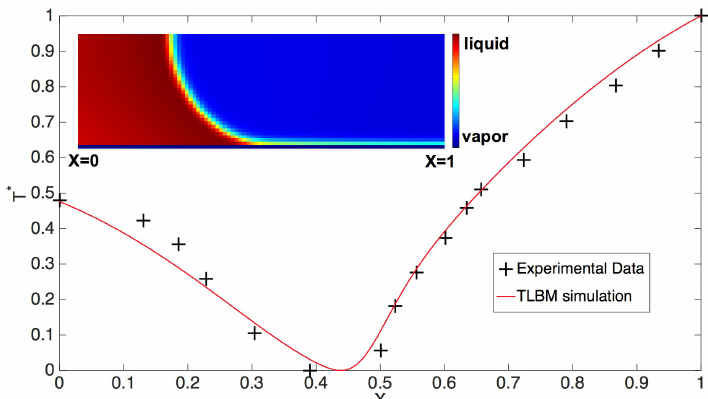
Figure 8. The wall temperature distribution under constant flux: black crosses are experimental data from [5]; red line is obtained by the thermal lattice Boltzmann method (TLBM) simulations; X and T ∗ are normalized location and temperature, respectively; density profile of the half channel is presented in the mini